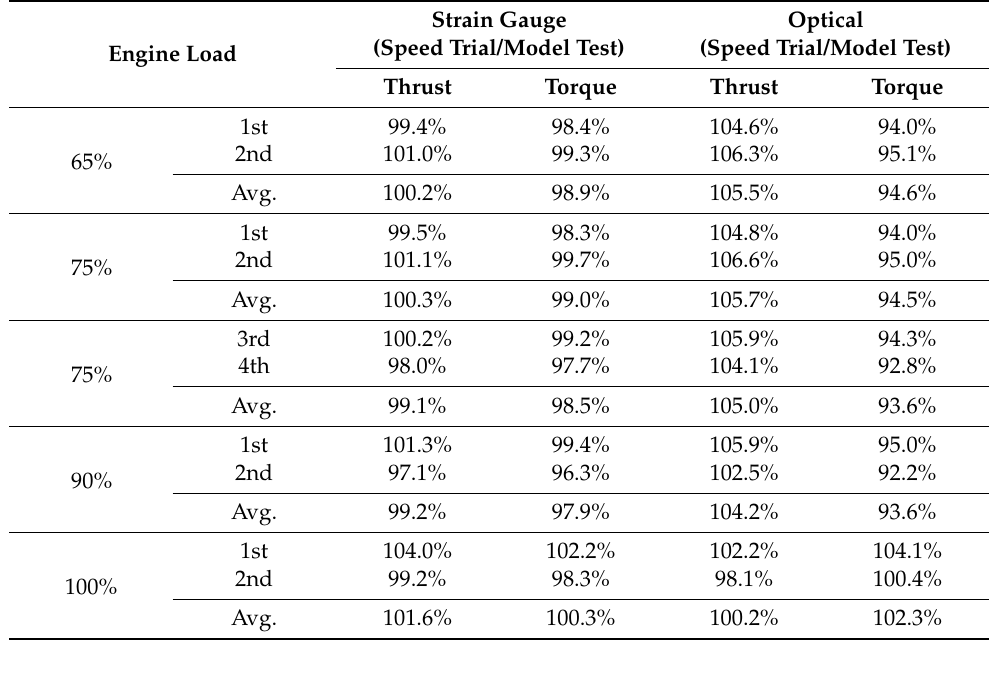
Table 2. Difference ratio between speed trial measurement and prediction results based on model test of the first vessel.